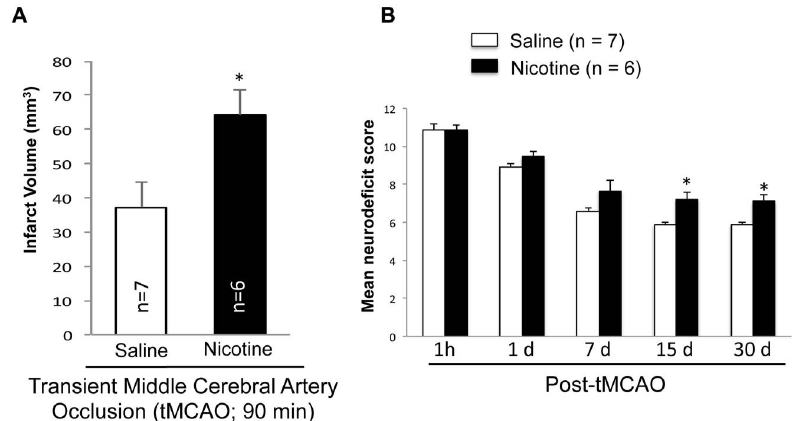
Figure 3. Nicotine increases infarct volume after tMCAO. ( A ) Infarct volume was measured by analyzing lesions after rats were subjected to 90 min of tMCAO. Volume was measured in mm 3 . ( B ) Neurodeficit score was measured in rats post tMCAO. Higher scores represent a greater neurodeficit. Nicotine-treated rats showed significantly higher neurodeficit scores after ischemia when compared to control. Data presented are mean ± SEM (* p < 0.05)